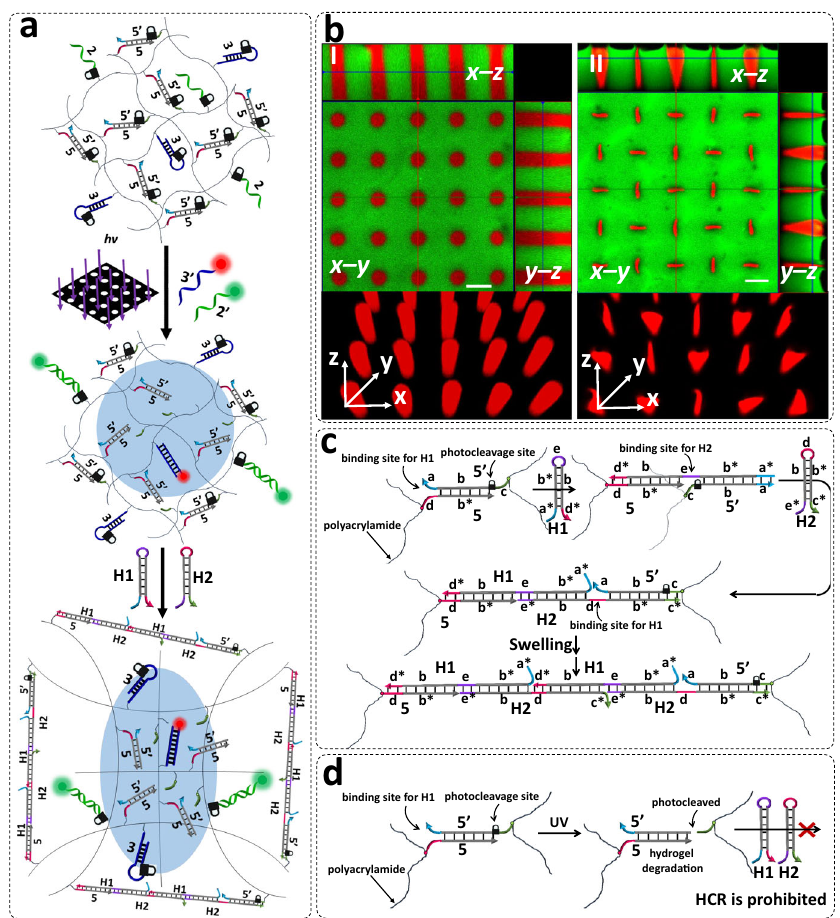
Fig. 6 DNA hybridization chain reaction (HCR) dictates site-speci fi c swelling of hydrogel fi lms for pattern modulation. a Photolithographic patterning of a o-nitrobenzylphosphate ester photoprotected hydrogel that yields non-crosslinked periodically spaced holes on a continuous hydrogel fi lm crosslinked by photoprotected (5)/(5 ’ ) duplexes and functionalized with (2) and hairpin (3). The photolithographic process leads to the guided hybridization of the TAMRA-(3 ’ ) and FAM-(2 ’ ) with activated (3) and (2), associated with the hole domains and the continuous hydrogel, respectively. The intact crosslinker units bridging the continuous hydrogel fi lm initiate the hybridization chain reaction (HCR), in the presence of hairpins H1 and H2 to yield long-chain nucleic acid wires bridging the polyacrylamide scaffold. b Panel I — Three-dimensional confocal fl uorescence microscope images and reconstructed image (bottom panel I) of the spatially-separated periodic circular (cylindrical) patterned structures generated according to Fig. 6a. Panel II — Three-dimensional confocal microcopy image of the spatially-separated orthogonal ellipsoid microstructures and the reconstructed structures (bottom panel II) generated upon the forced transition of the circular patterned domains into the ellipsoid structures as a result of the HCR process proceeding in the continuous hydrogel fi lm according to Fig. 6c. Scale bars correspond to 50 μ m. c Schematic mechanism of the hybridization chain reaction (HCR) initiated by the duplexes (5)/(5 ’ ) in the presence of hairpins H1 and H2, leading to long DNA duplex wires bridging the polyacrylamide network. d Schematic inhibition of the HCR process by the photodeprotected duplexes (5)/(5 ’ ) positioned in the “ hole ” domains. N = 4 independent experiments were